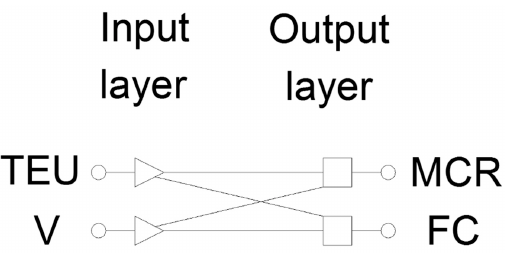
Figure 5. The structure of the artificial neural network to estimate the engine power (MCR) and fuel consumption (FC) of container carriers, where TEU—the number of containers, V—speed. These values are relatively low. The statistics for the test sets are especially important since the data in these sets are only used to test the networks, not to develop them. The test set statistic values were used to verify the ability of the neural network to generalize new cases. The RMSE values for test data vary slightly from the statistics for training and validation sets for all developed networks. Regressions between the estimated and observed values through the use of the ANNs are shown in Figures 6–8. These figures show the values of engine power (MCR) and fuel consumption (FC), observed and calculated by the use of neural networks, broken down into training, validation, test and